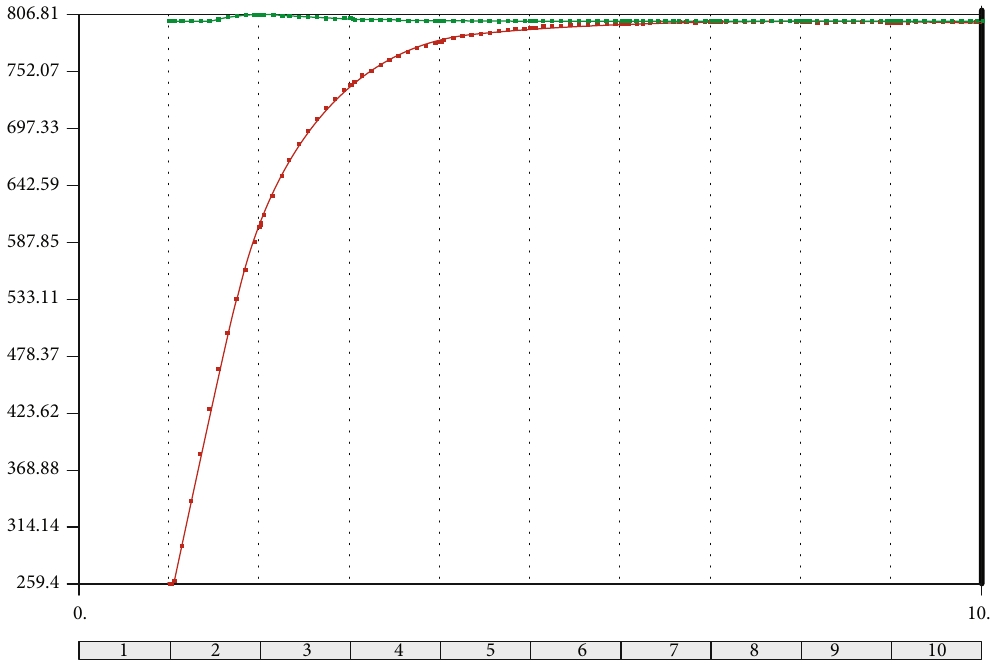
Figure 11: Overall temperature distribution over the